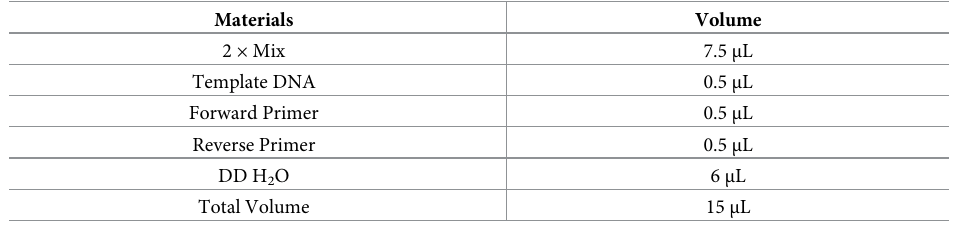
Table 1. C . sartagoforme 16S rDNA PCR reaction